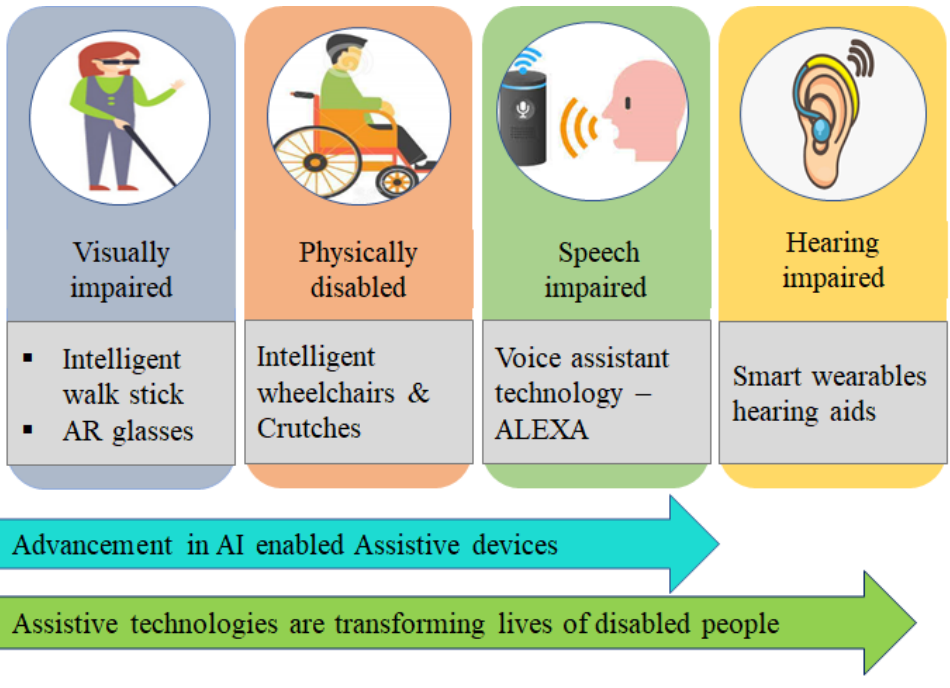
Figure 9. Intelligent Sensing for Visually